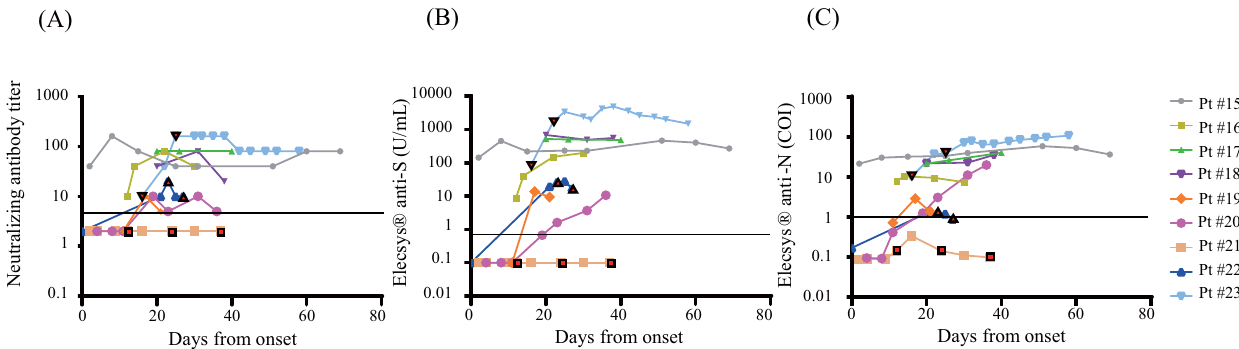
Fig 4. Longitudinal change of antibodies in Group S. Levels of SARS-CoV-2 antibodies in 9 severe to critical cases (Group S) were tested. (A) Neutralizing antibody (B) Elecsys 1 anti-S (C) Elecsys 1 anti-N. Colored boxes represent the days of plasmapheresis. The vertical axes are in logarithmic notation.